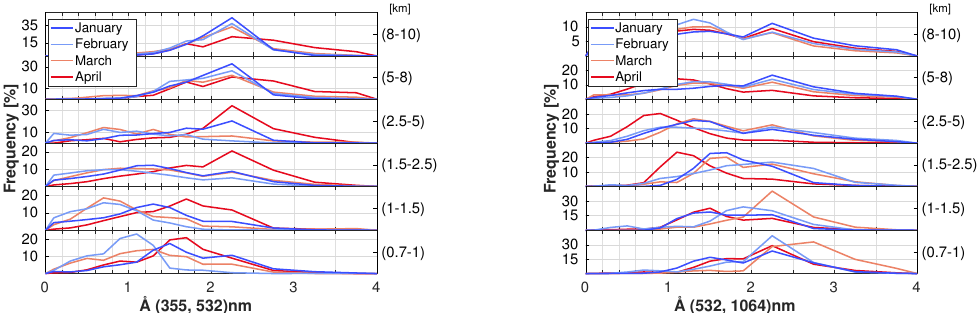
Figure A1. Frequencypolygon of the Ångström exponent for different height intervals and months. Left: calculated with 355nm and 532nm; right: calculated with 532nm and 1064nm. The trend differs for different wavelength